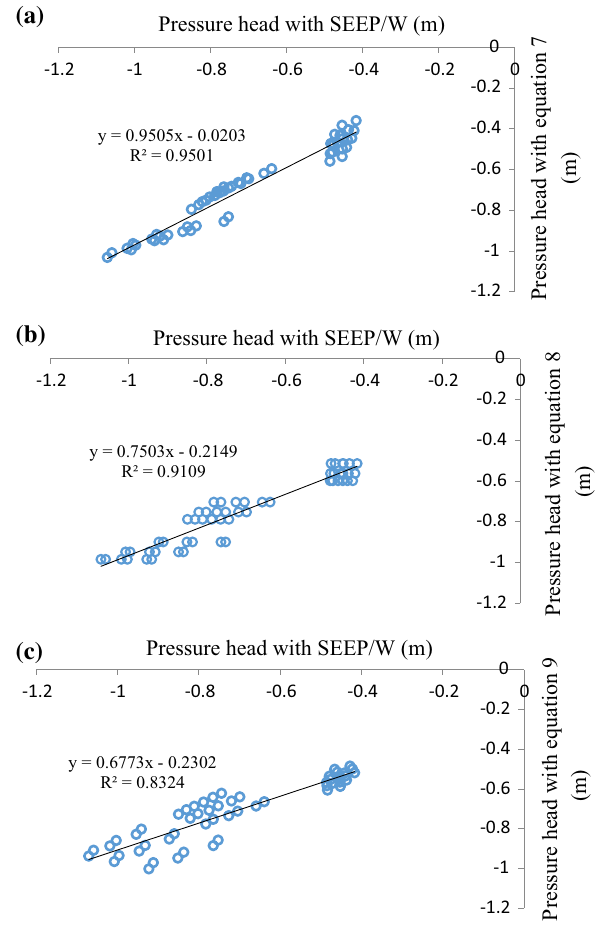
Fig. 17 Variation pressure head (numerical simulation) versus pres- sure head (regression equation) for a Eq. 8, b Eq. 9, c Eq. 10